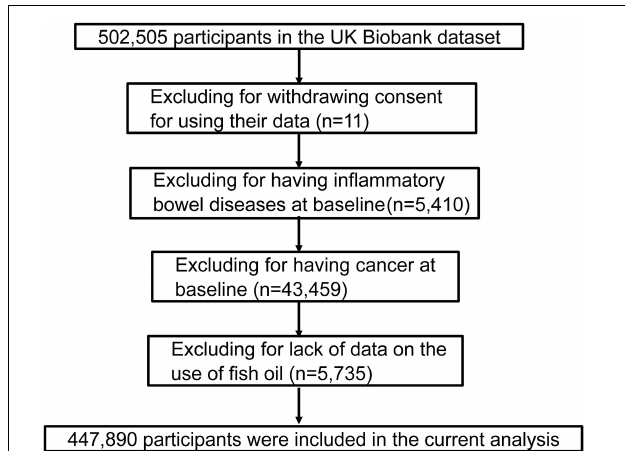
FIGURE 1 | Flow chart of eligible participants in this